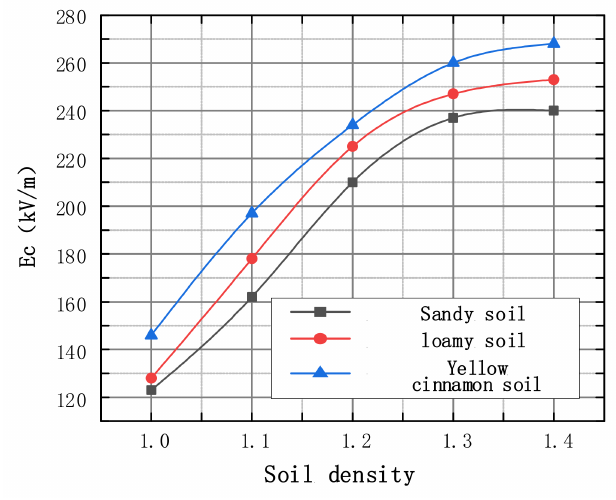
Figure 7. The influence of soil density on the critical breakdown field